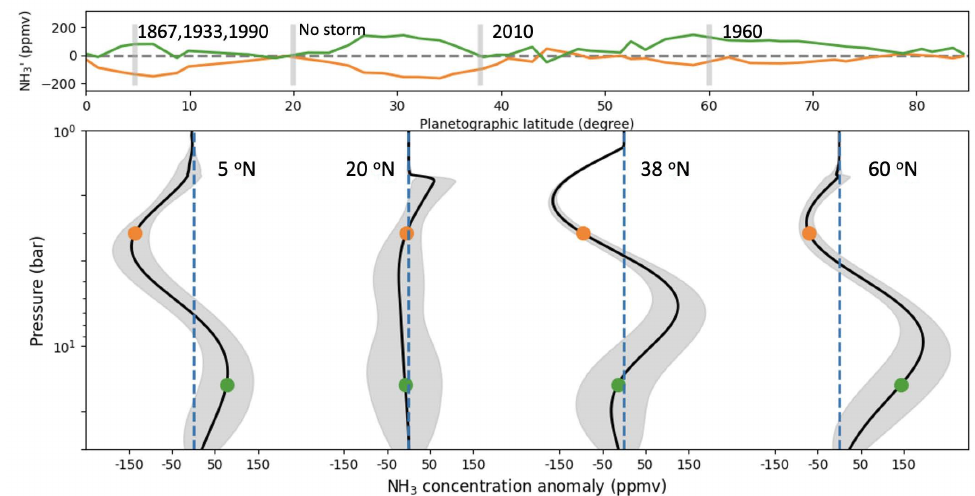
Figure 13. Retrievals of the ammonia vapor concentration anomaly in Saturn’s atmosphere with respect to a uniformly mixed atmosphere up to the ammonia ice cloud (above which NH 3 follows the saturated vapor curve), as derived from the 2015 VLA data. The top panel shows the horizontal cross-section at 3 bars (orange) and 15 bars (green) respectively. The locations and the years of the previous giant storms are annotated in the figure. (Courtesy: Cheng